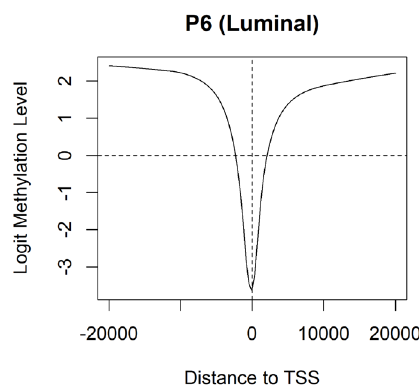
Figure 3. Methylation level by distance to the nearest gene TSS. Results are averaged over all genes. Negative distances are downstream of